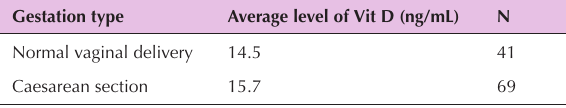
Table 3. Gestation type and mothers’ vitamin D level Gestation